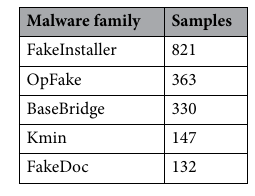
Table 1. Malware samples in Drebin from Top 5